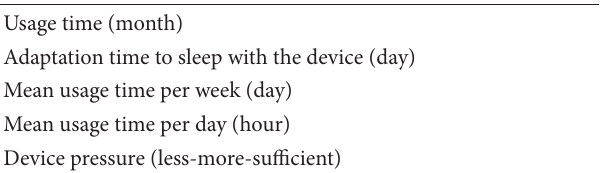
Table 2: Definition of evaluation of the problems that can be occur during the usage of